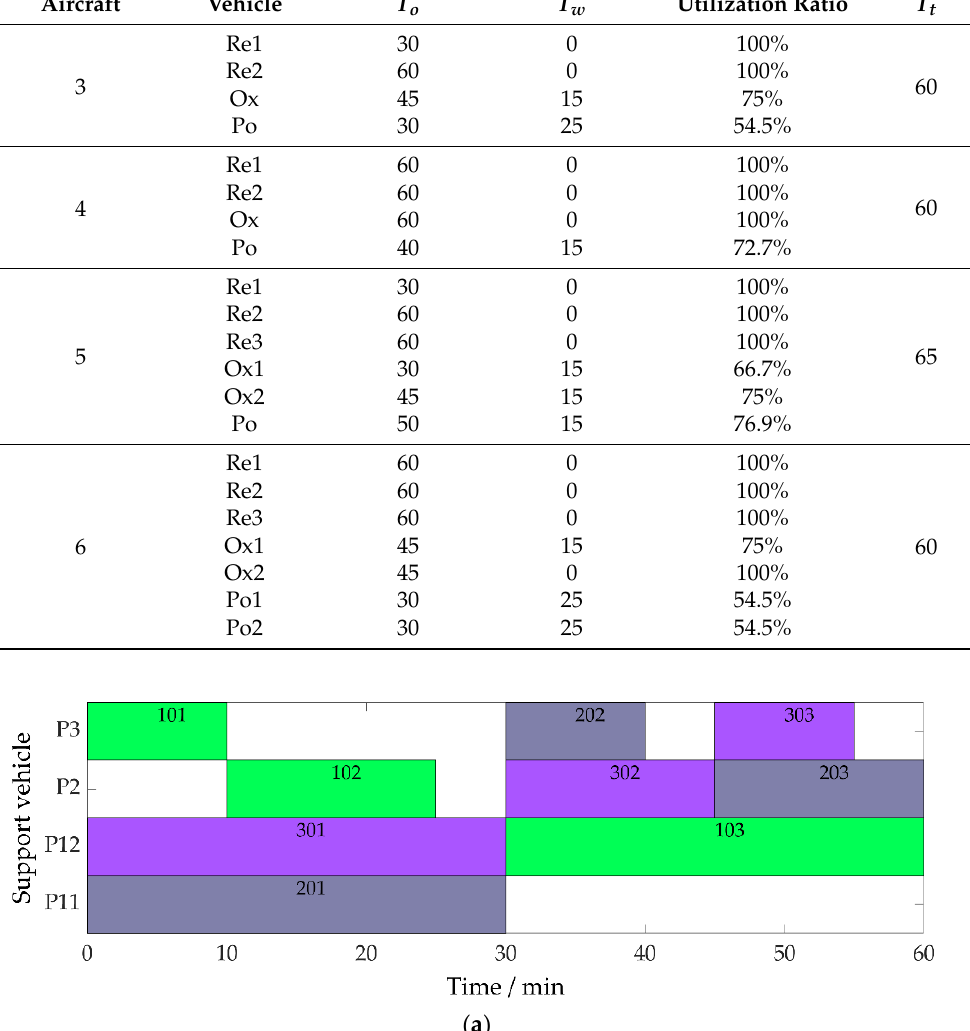
Figure 10. Change of population fitness value. ( a ) 3 aircraft, ( b ) 4 aircraft, ( c ) 5 aircraft, ( d ) 6 aircraft.